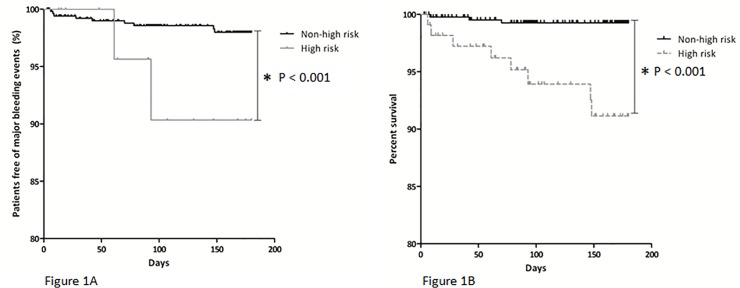
Percent survival of major bleeding complications by Kaplan-Meier life table method, stratified to A) non-high (HAS-BLED score < 4) or high-risk (HAS-BLED score ≥ 4) of major bleeds; * p = 0.0007 by Log-Rank test, HR of 10.8 (95% CI 2.3–50.0) or B) non-high (HAS-BLED score < 3) or high-risk (HAS-BLED score ≥ 3) of major bleeds; * p <0.0001 by Log-Rank test, HR of 8.7 (95%CI2.7–28.4).